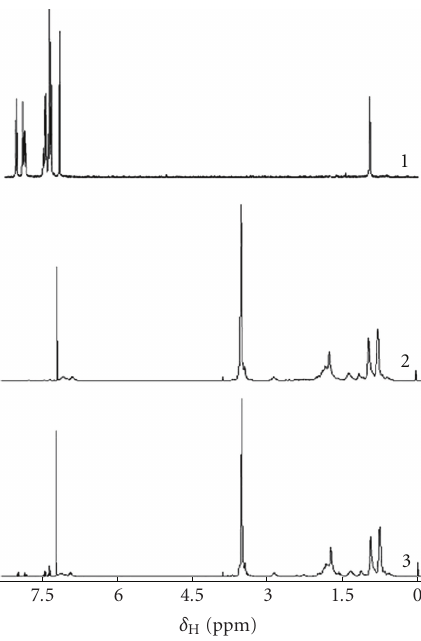
Figure 4: 1 H NMR spectra of Diimide (1), PMMA (2), and PMMA obtained in the presence of 20 wt.% of Diimide